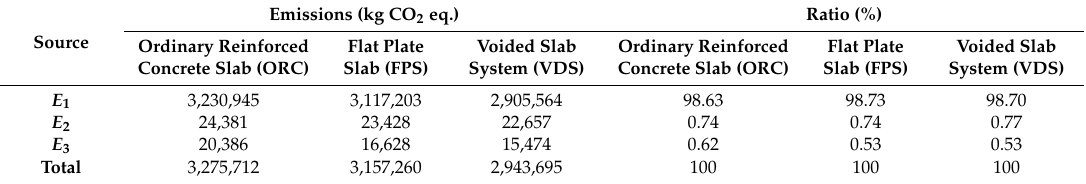
Table 5. Total carbon dioxide emissions of each slab system.